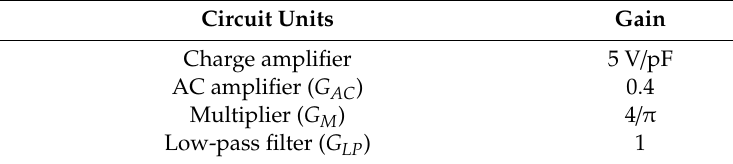
Table 1. The gains of each part in the capacitive